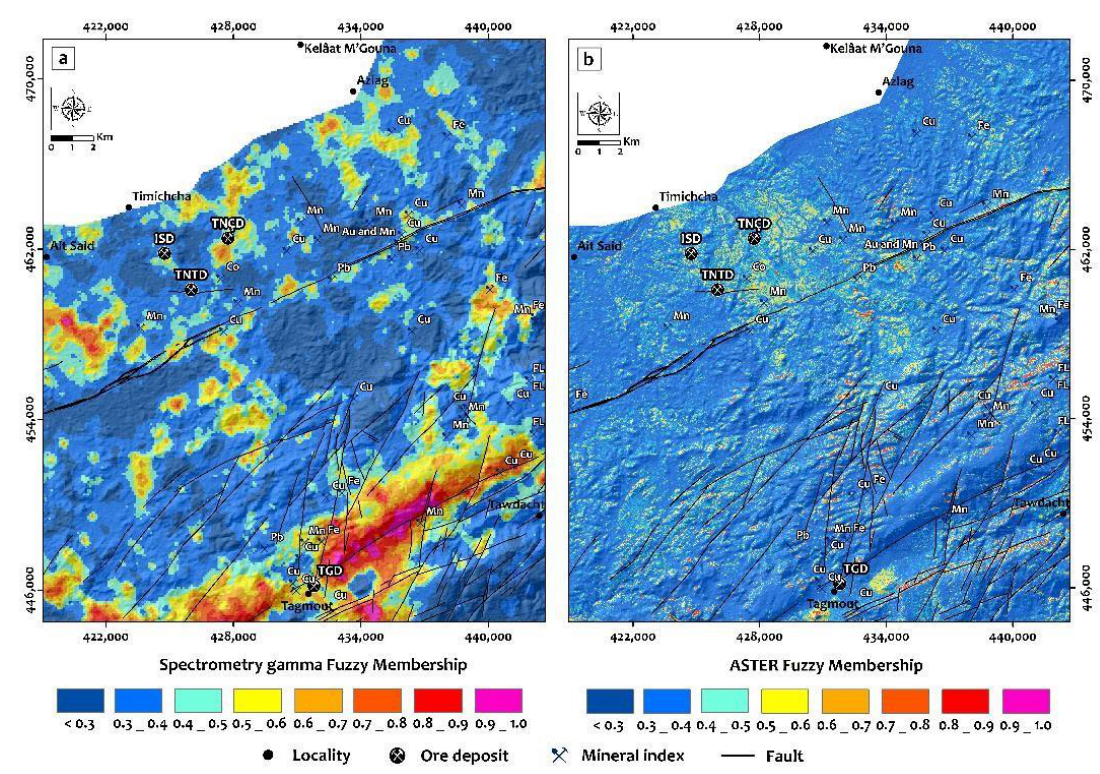
Figure 6. Mineral prospectivity maps: ( a ) mineral prospectivity map derived from natural gamma spectrometry data. ( b ) Mineral prospectivity map derived from ASTER image.